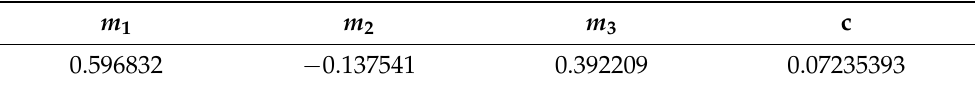
Table 6. MLR with dimensionality reduction: coefficients and intercept information.